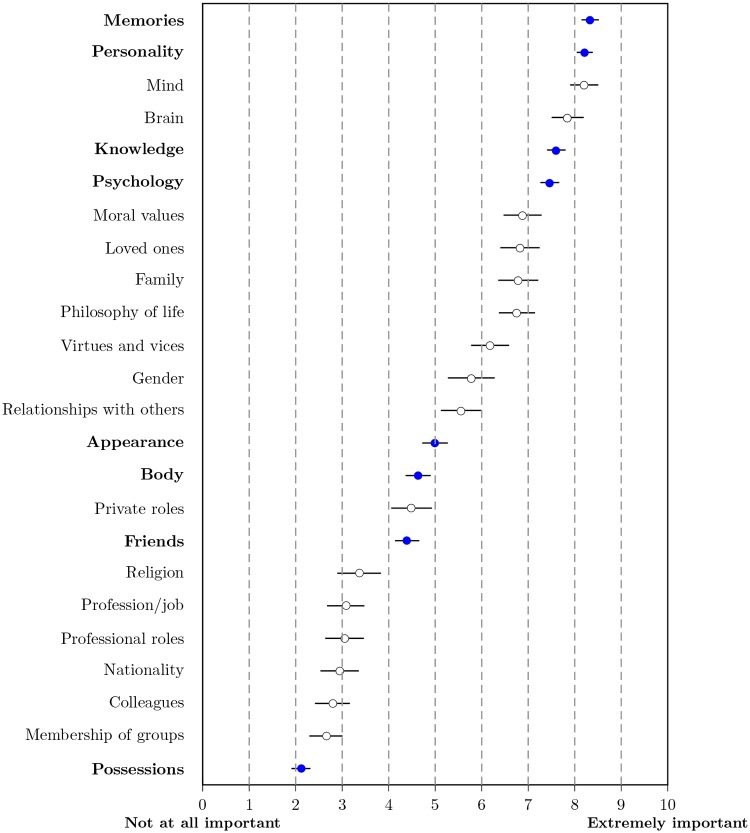
Importance assigned to attributes for determining identity between persons (300 ≤ N ≤ 817) in Study 2.Dots and bars show means and corresponding 99% CIs. All participants rated the eight dimensions marked with filled dots and a randomly selected subset of six other dimensions (balanced across participants). Elements of the five scenario dimensions are labeled in bold.